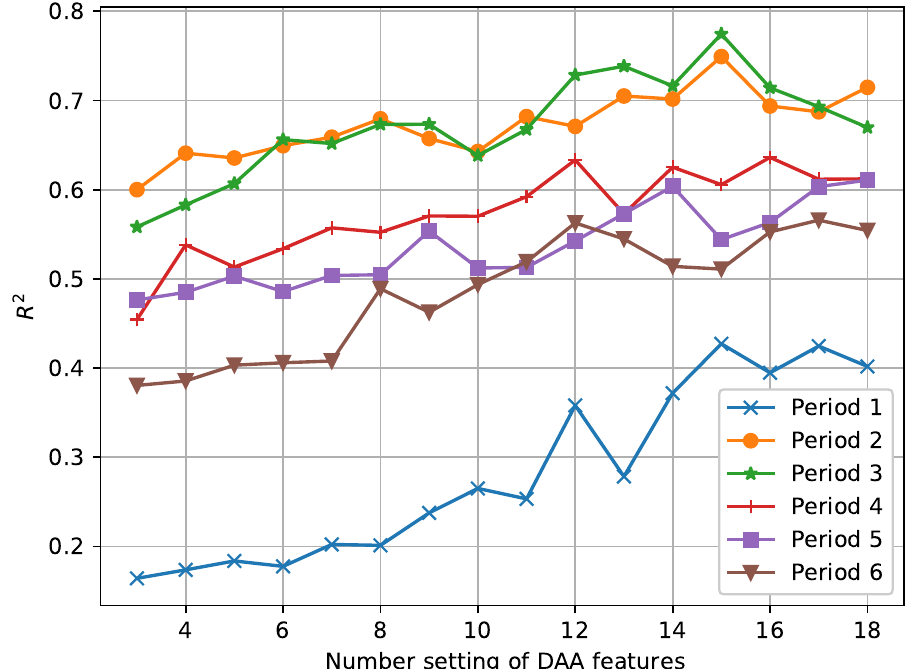
Figure 2. Biomass prediction accuracy using MLR models with varied archetype